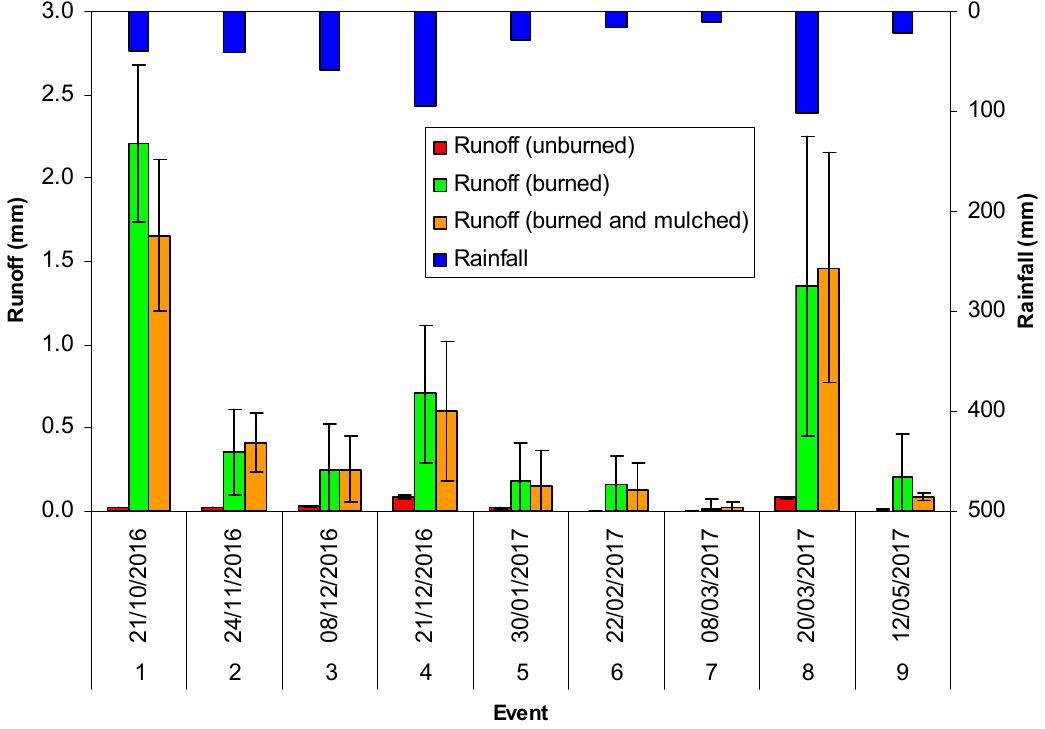
Figure 2. Rainfall and runoff volumes observed in forest plots subject to prescribed fire (Lezuza, Castilla La Mancha, Spain). Vertical bars are the standard deviations.